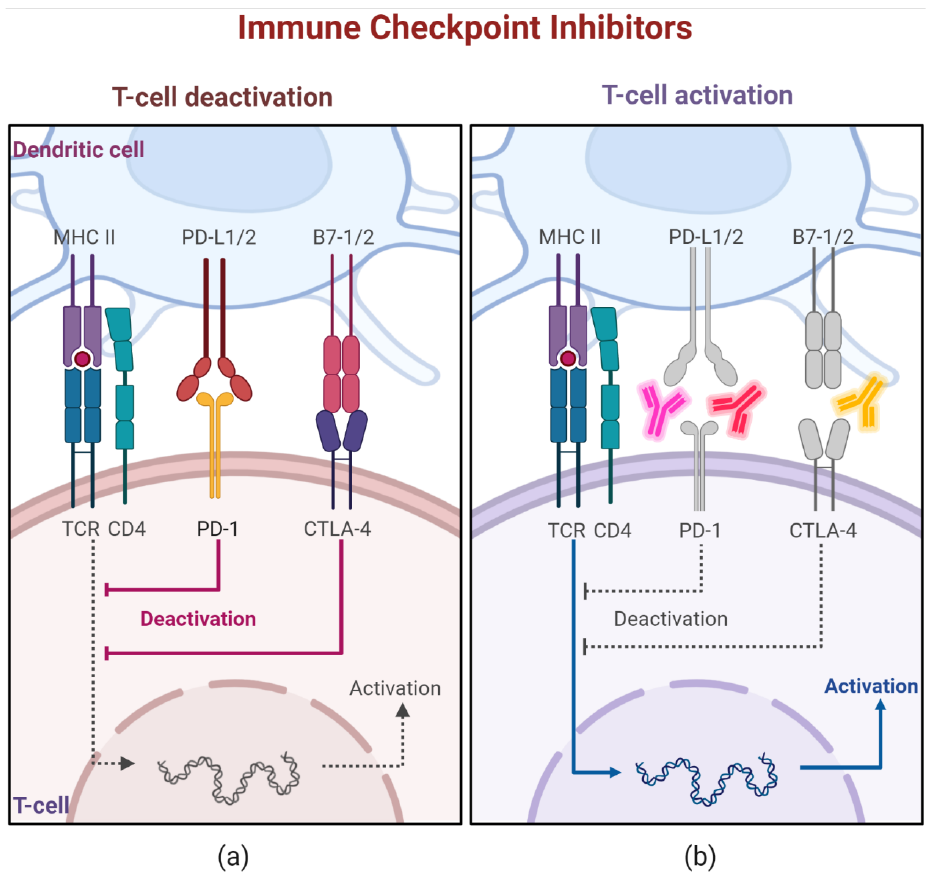
Figure 1. T cell activation through checkpoint inhibitors. A schematic presentation of anti-PD-1/PD- L1 and anti-CTLA-4 agents in action. ( a ) APCs, such as dendritic cells, present processed peptides to T cells on MHC molecules. Upon activation, T cell gradually expresses on its membrane the CTLA-4. When it binds to B7-1/2, it initiates co-inhibition pathways that lead to T cell anergy. In peripheral tissues, activated T cell can be de-activated by the binding of PD-1 to PD-L1 or PD-L2. ( b ) The anti-CTLA-4 and anti-PD-1/PD-L1 monoclonal antibodies block those inhibitory pathways resulting in effective anti-tumor T lymphocyte responses.